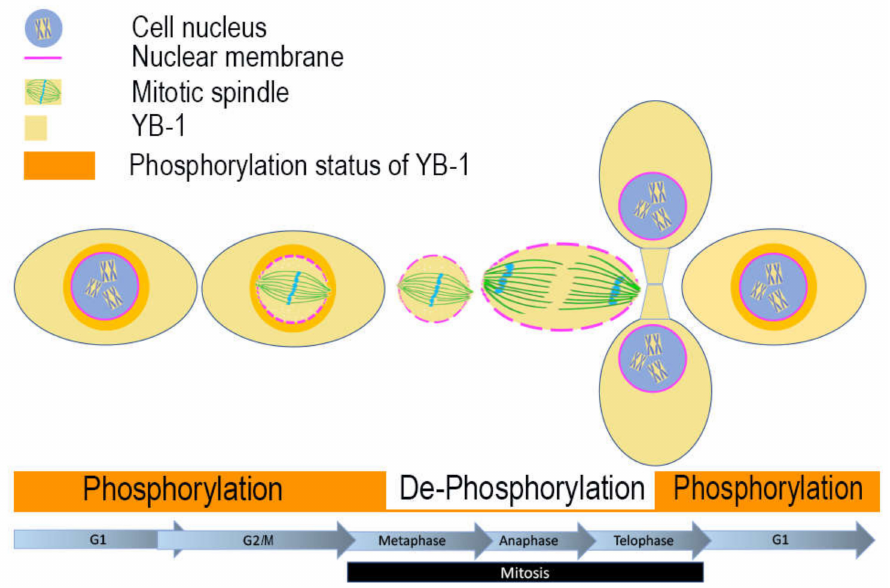
Figure 7. Proposed model of YB-1 location during cell cycle phases. YB-1 is shown in yellow. The phosphorylation status of YB-1 is depicted by the orange blocks below the cell graphic. In G 1 phosphorylated YB-1 is cytoplasmic and becomes increasingly perinuclear as the cell moves from G 1 / S / G 2 . Just prior to the breakdown of the nuclear membrane in late G 2 (represented by the broken magenta line), YB-1 is dephosphorylated, increasing the accessibility of the NLS enabling its movement into the nucleus where it remains during mitosis until the nuclear envelope is re-established in late telophase. Following phosphorylation and increased accessibility of the CRS, YB-1 moves to the cytoplasmic compartment. The mitotic spindle is depicted in green; chromosomes in light